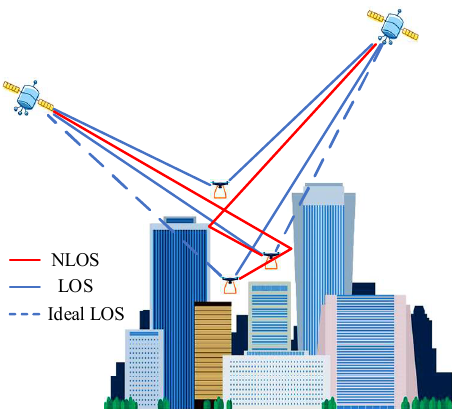
Figure 1. Illustration of LOS and NLOS.